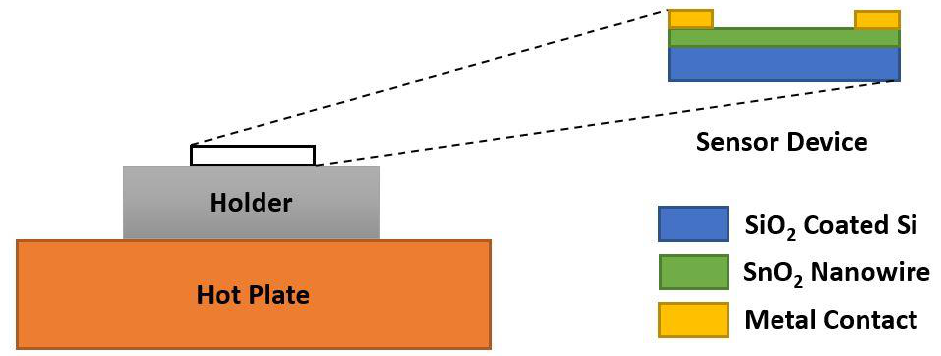
Figure 7. Fabricated SnO 2 nanowire sensor device structure.